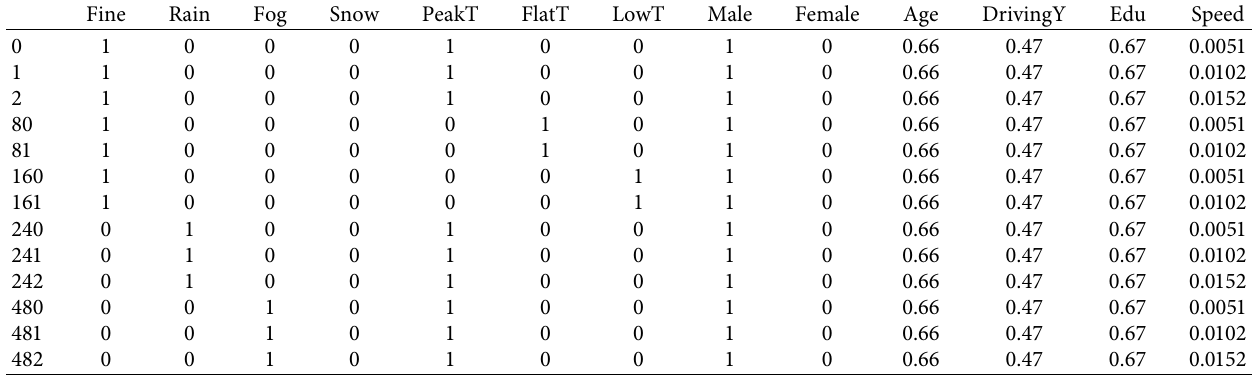
Table 10: Samples of typical drivers (partial).